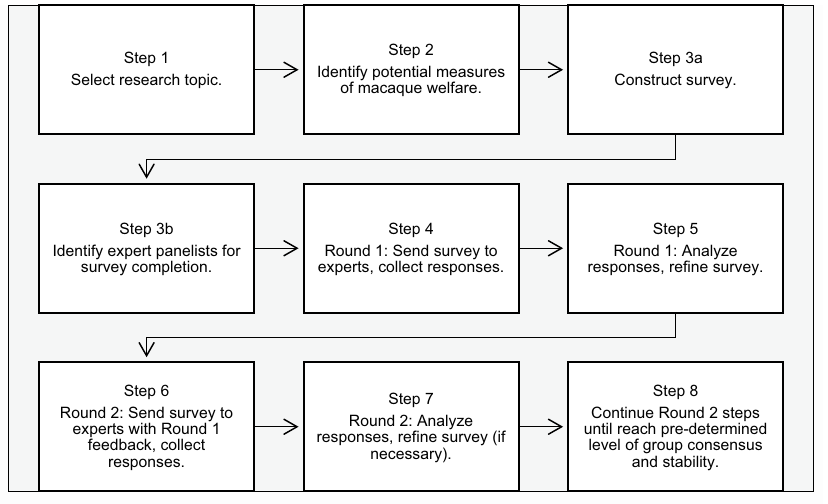
Figure 1. Steps in a modified Delphi